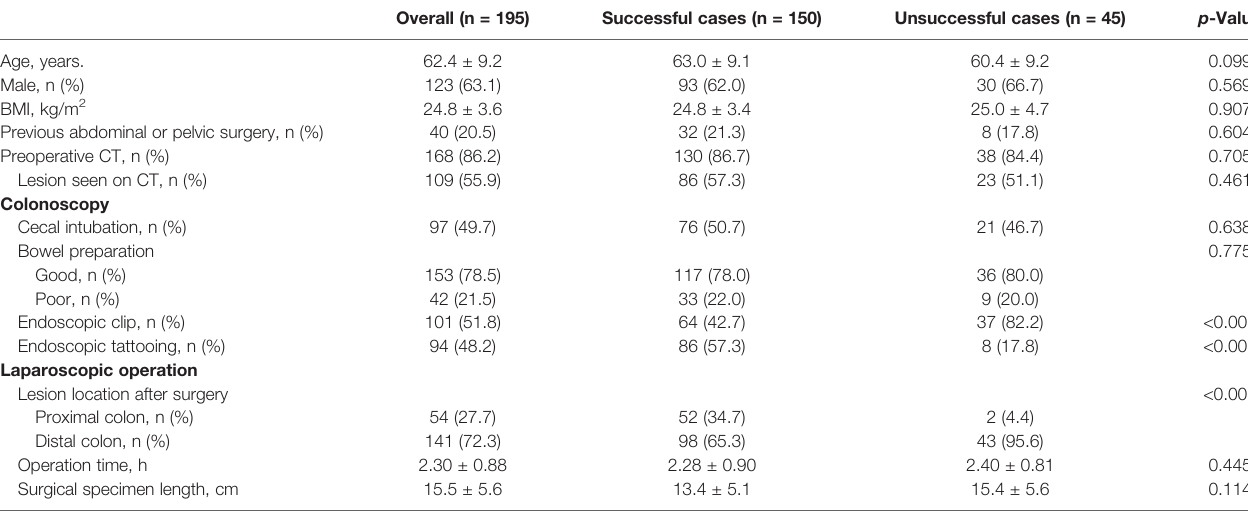
TABLE 2 | The demographic and clinical characteristics of the study patients in the endoscopic localization successful/unsuccessful group. Overall (n = 195) Age, years.